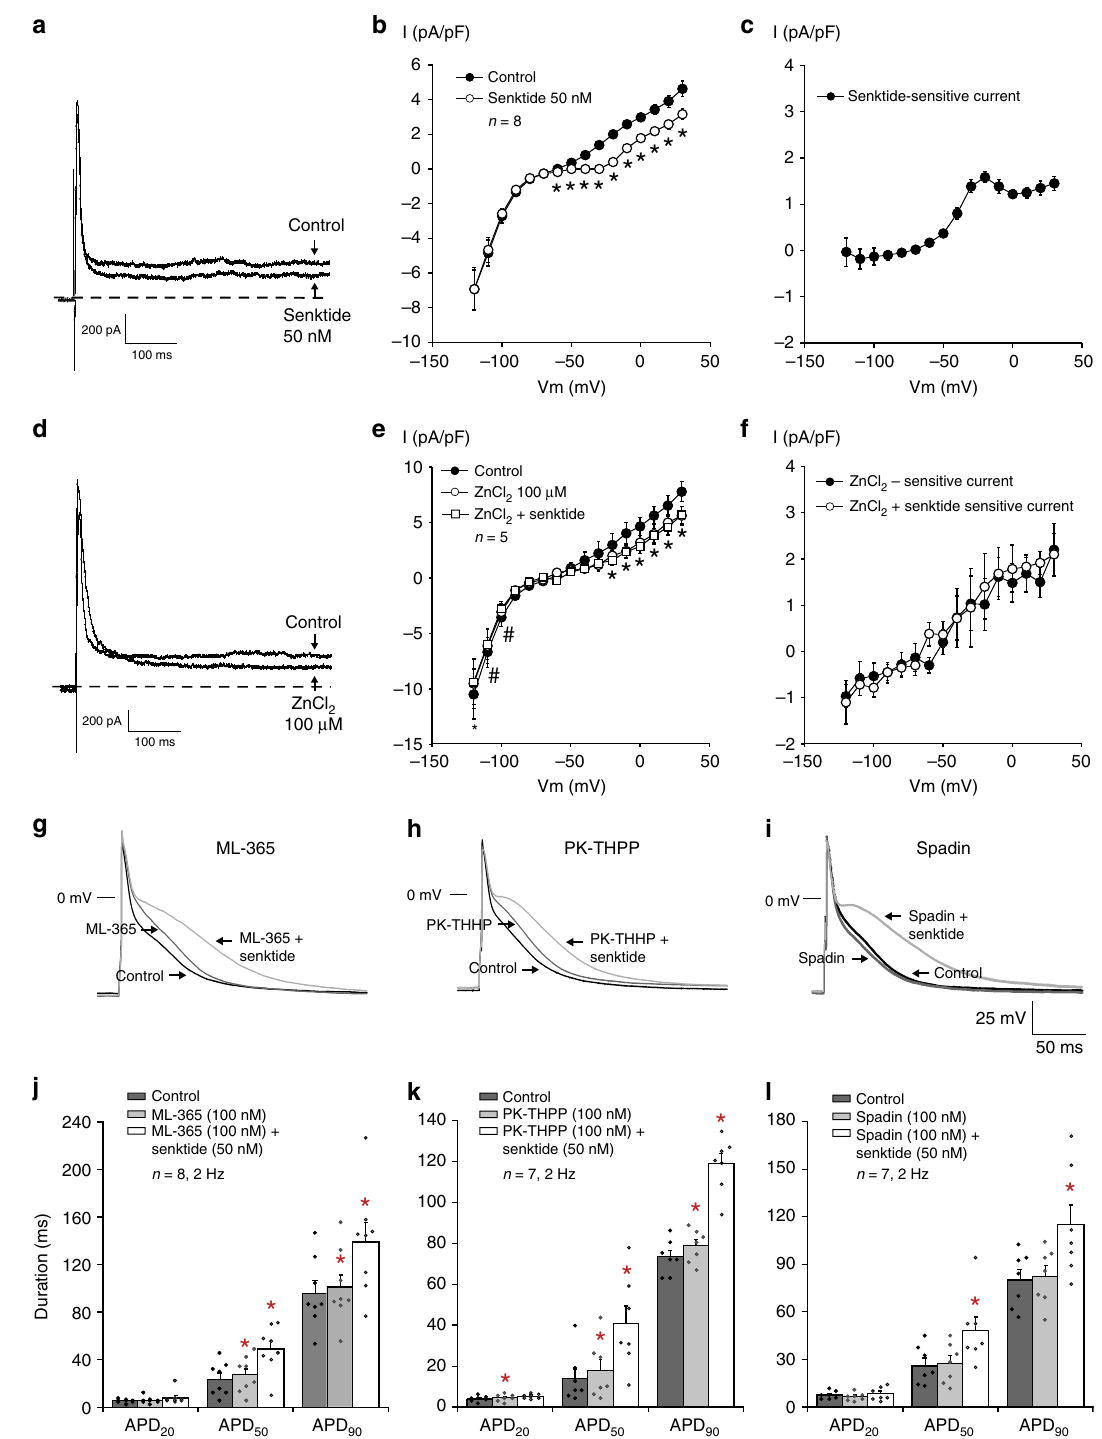
Fig. 6 Effects of Senktide and different K2P channel blockers on atrial electrophysiology. a – c Current tracings recorded at + 40 mV before (Control) and after application of 50 nM Senktide ( a ), associated average current – voltage I – V relationships of the steady-state current ( b ), and I – V relationships of Senktide-sensitive current ( c ) ( N = 4, n = 8, two-way RM ANOVA). d – f Current tracings recorded at + 40 mV before (Control) and after application of ZnCl 2 (100 µ M), followed by additional Senktide (50 nM) ( d ), associated average I – V relationships of the steady-state current ( e ), and average I – V relationships of ZnCl 2 -sensitive current ( f ). ( N = 4, n = 5, two-way RM ANOVA). g – i Atrial action potentials (AP) elicited at 2 Hz under control conditions (Control) and in the presence of 100 nM ML-365 ( g ), PK-THPP ( h ) and Spadin ( i ). j – l Bar graphs showing average values for AP duration at 20, 50 and 90% of repolarization (APD 20 , APD 50 and APD 90 ) before (Control) and after application of 100 nM ML-365 ( j , N = 4, n = 8), PK-THPP ( k , N = 3, n = 7), and Spadin ( l , N = 2, n = 7). One-way RM ANOVA. All values shown are mean ± SEM. * P < 0.05 vs.